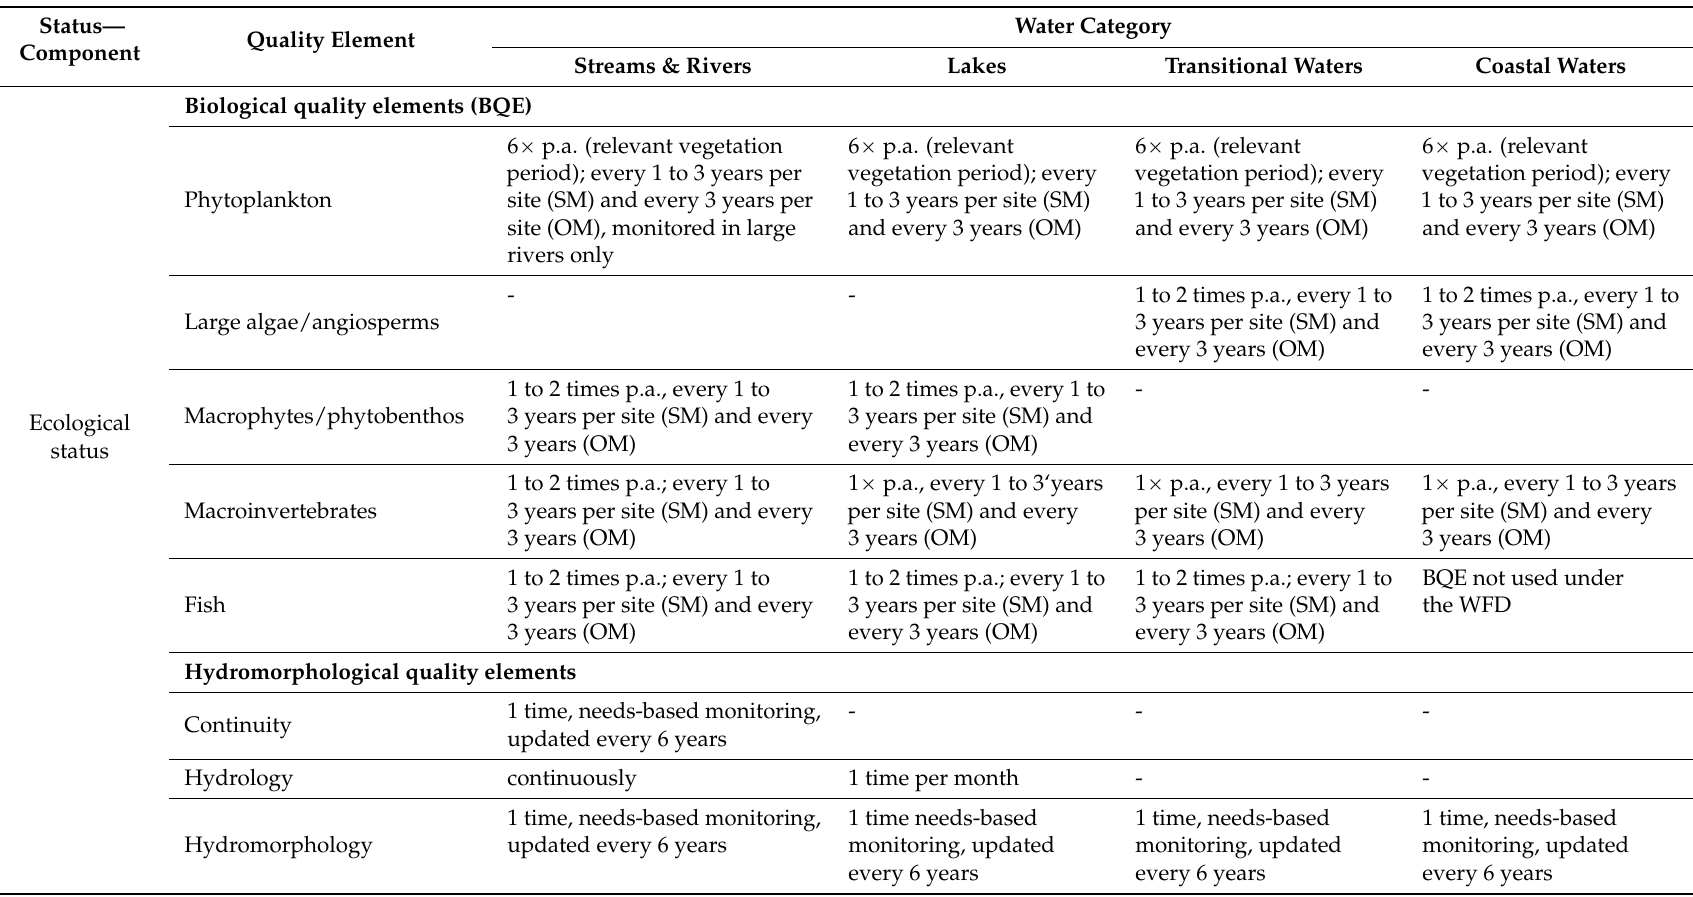
Table 2. Minimum requirements for monitoring frequencies and intervals for the quality elements under the ecological status and the chemical status as defined by the EC Water Framework Directive. OM = operational monitoring; SM = surveillance monitoring; p.a. = per annum, p.m. = per